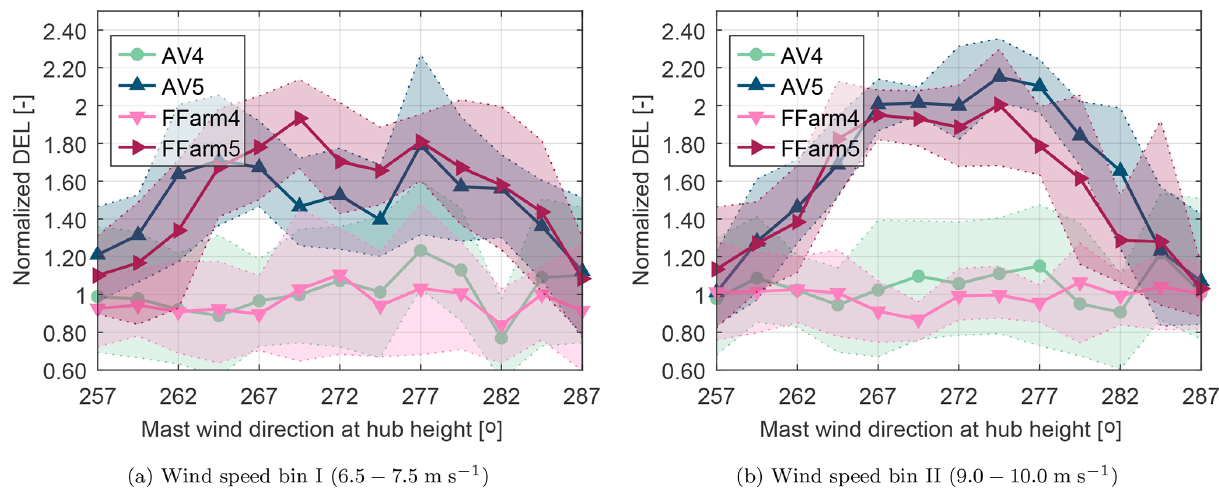
Figure 8. Comparison of the blade-root bending moment in the flapwise direction in waked conditions between measurements (AV4, AV5) and simulations (FFarm4, FFarm5). Statistics are shown as mean values per wind direction bin. The shaded area indicates the 15th and 85th percentiles.